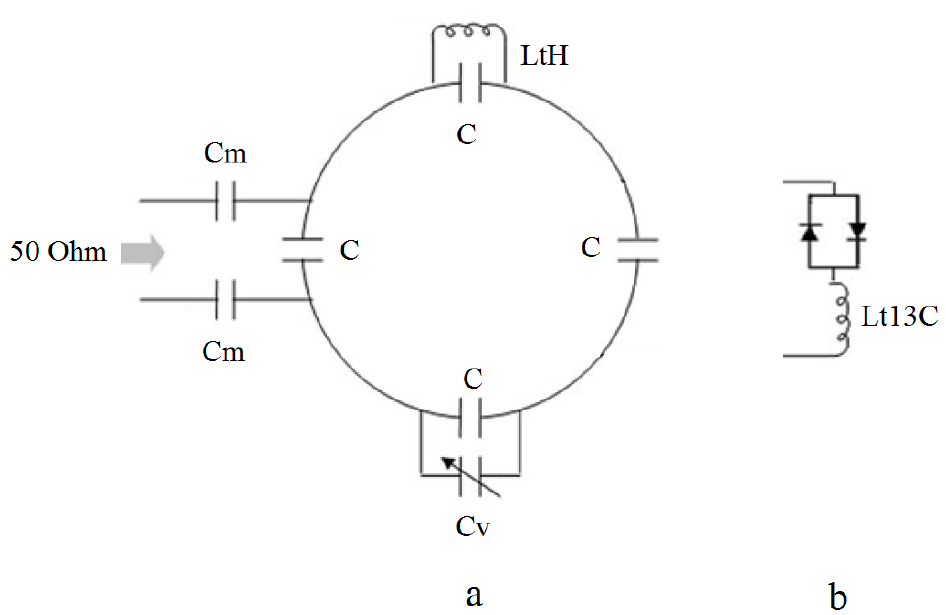
Figure 4. ( a ) TX/RX circular coil; ( b ) Decoupling circuit for the RX-only circular coil. C represents the high-quality capacitors (ATC 100C—American Technical Ceramics, Huntington Station, NY, USA) employed for the coil tuning at f 0 = 32.13 MHz, while C v is a variable capacitor (AP40HV Voltronics, Voltronics, Salisbury, MD, USA) useful for the coil fine-tuning within the MR system.